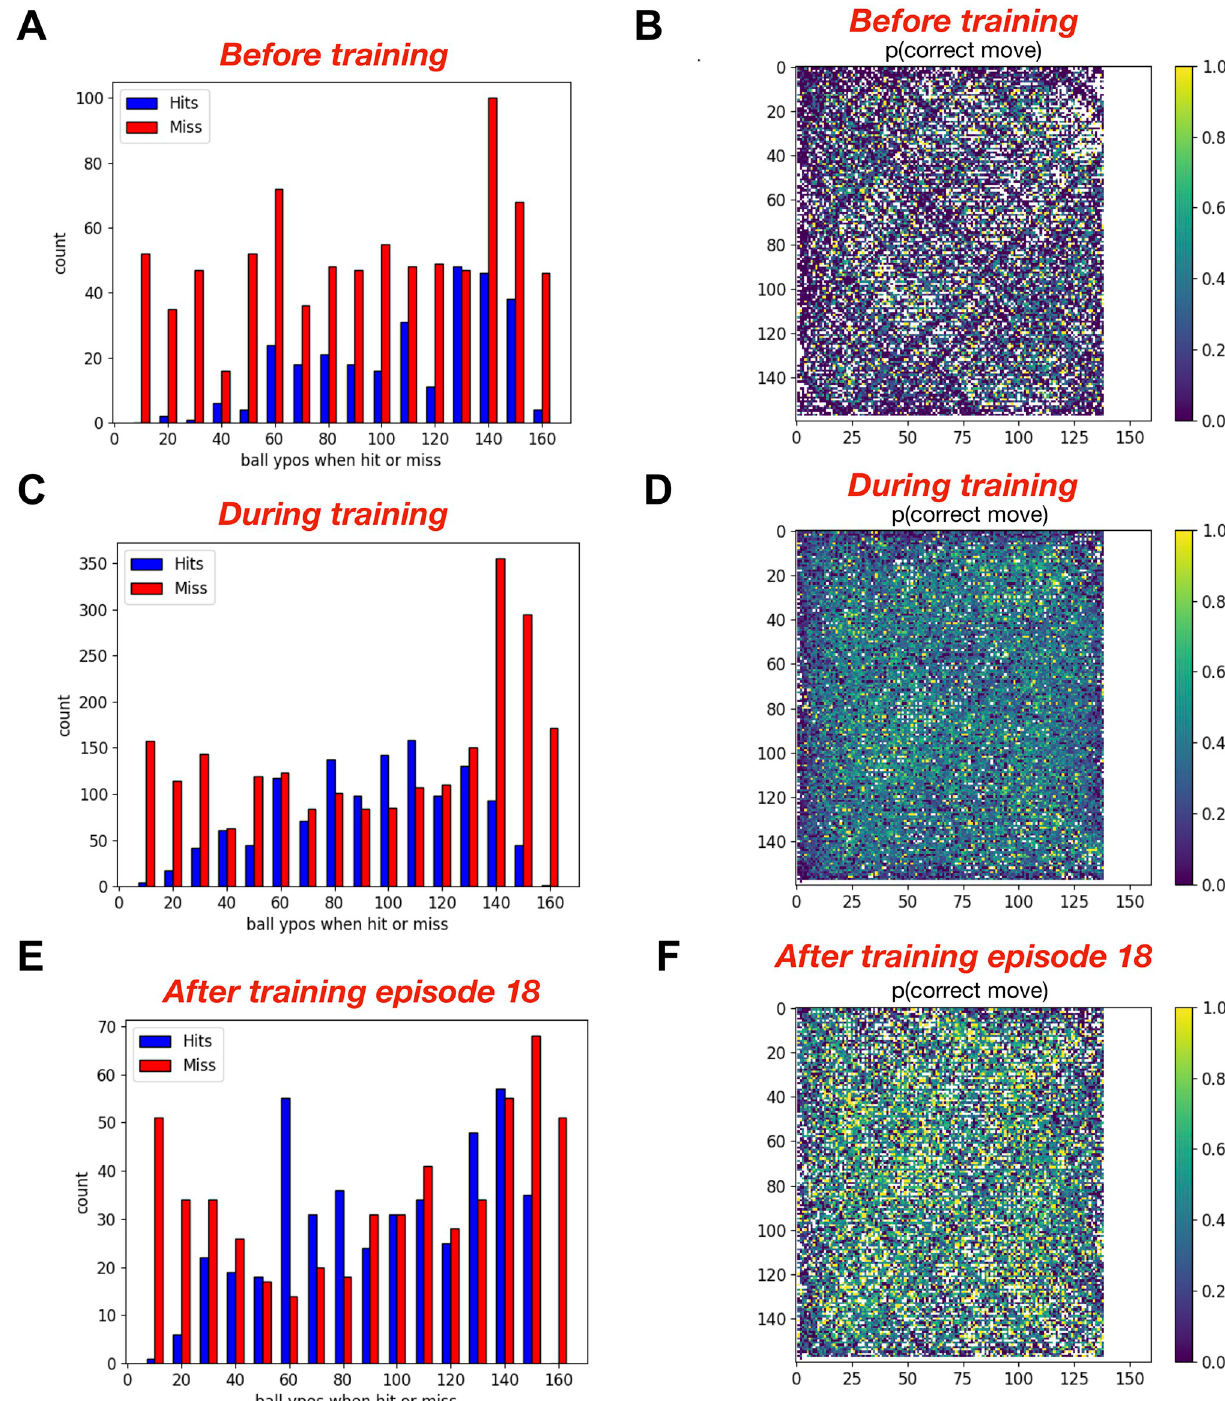
Fig 5. The feedforward spiking neuronal network model learned to perform better for the ball trajectories towards the center compared to the ball trajectories towards the corners of the court. The bar plots in A,C and E show the number of ‘Hits’ and the number of ‘Misses’ against the ball’s vertical position (ypos) when crossing the racket for the model before, during and after training respectively. The heatmaps in B, D and F show the probability of a correct move for each ball location in the court for the model before, during and after training respectively. The color at each pixel in the heatmaps shows the probability of correct action when the ball was at that location based on the projected Hit coordinates (when the action is the same as the proposed action). The white pixels represent the locations never parsed by the ball. Similarly the white space on the right side of each heatmap indicates the region, where no proposed action was available for the model racket (p(correct move) = NaN) as the ball had already passed the racket on the right side of the court.